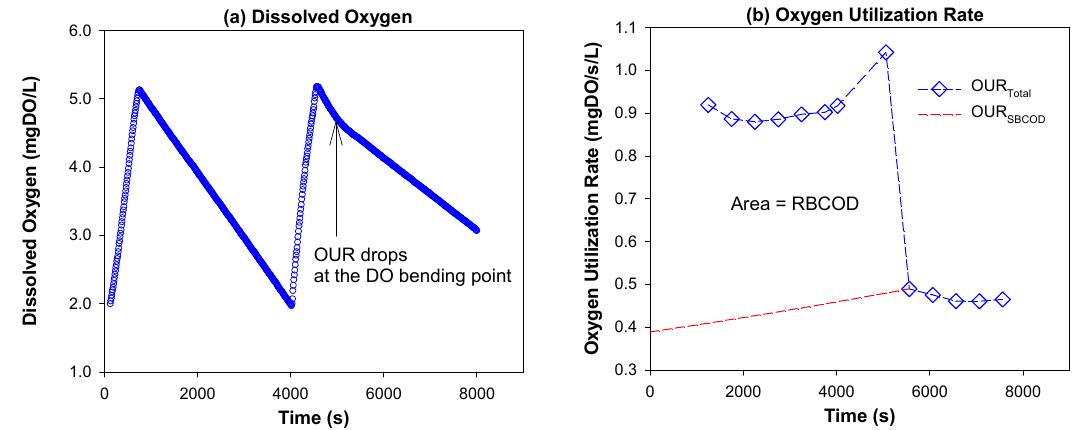
Figure 2. Results from a respirometer test, measuring the readily biodegradable COD (RBCOD) concentration in wastewater organic matter. ( a , b ) illustrate dissolved oxygen (DO) concentrations and oxygen utilization rate, respectively, with increasing time.